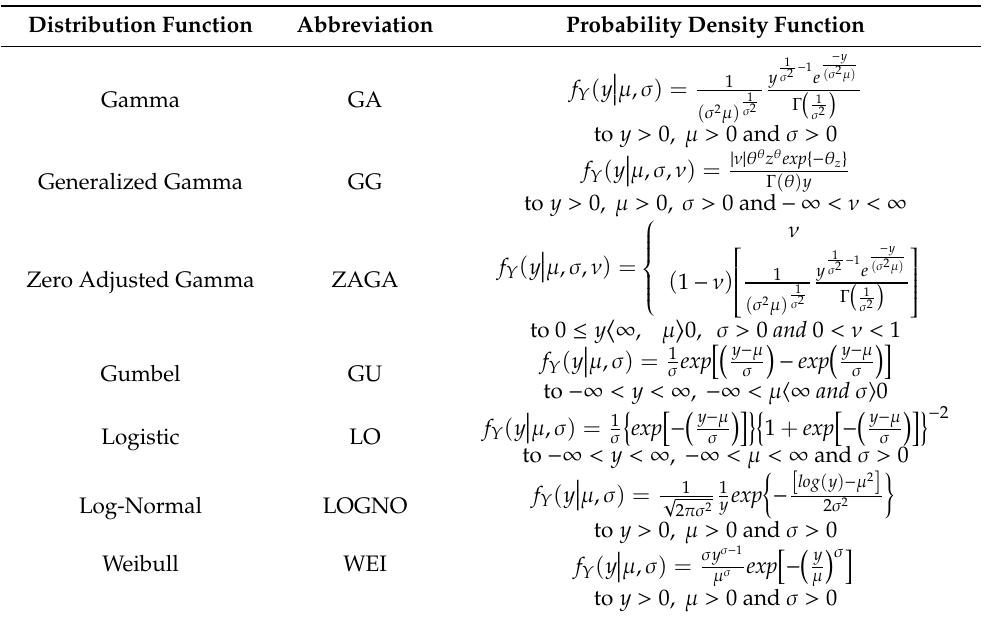
Table 1. Summary of the seven distributions considered in the